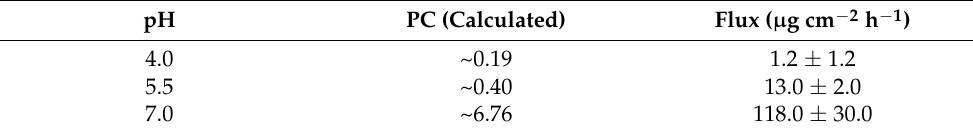
Table 2. PC and flux for lignocaine HCl at different donor pH values. For flux experiments, 2% lignocaine hydrochloride was applied in buffer solutions ( n = 3, values represent the mean ± S.D.) Adapted with permission from [29], Elsevier, 2000.